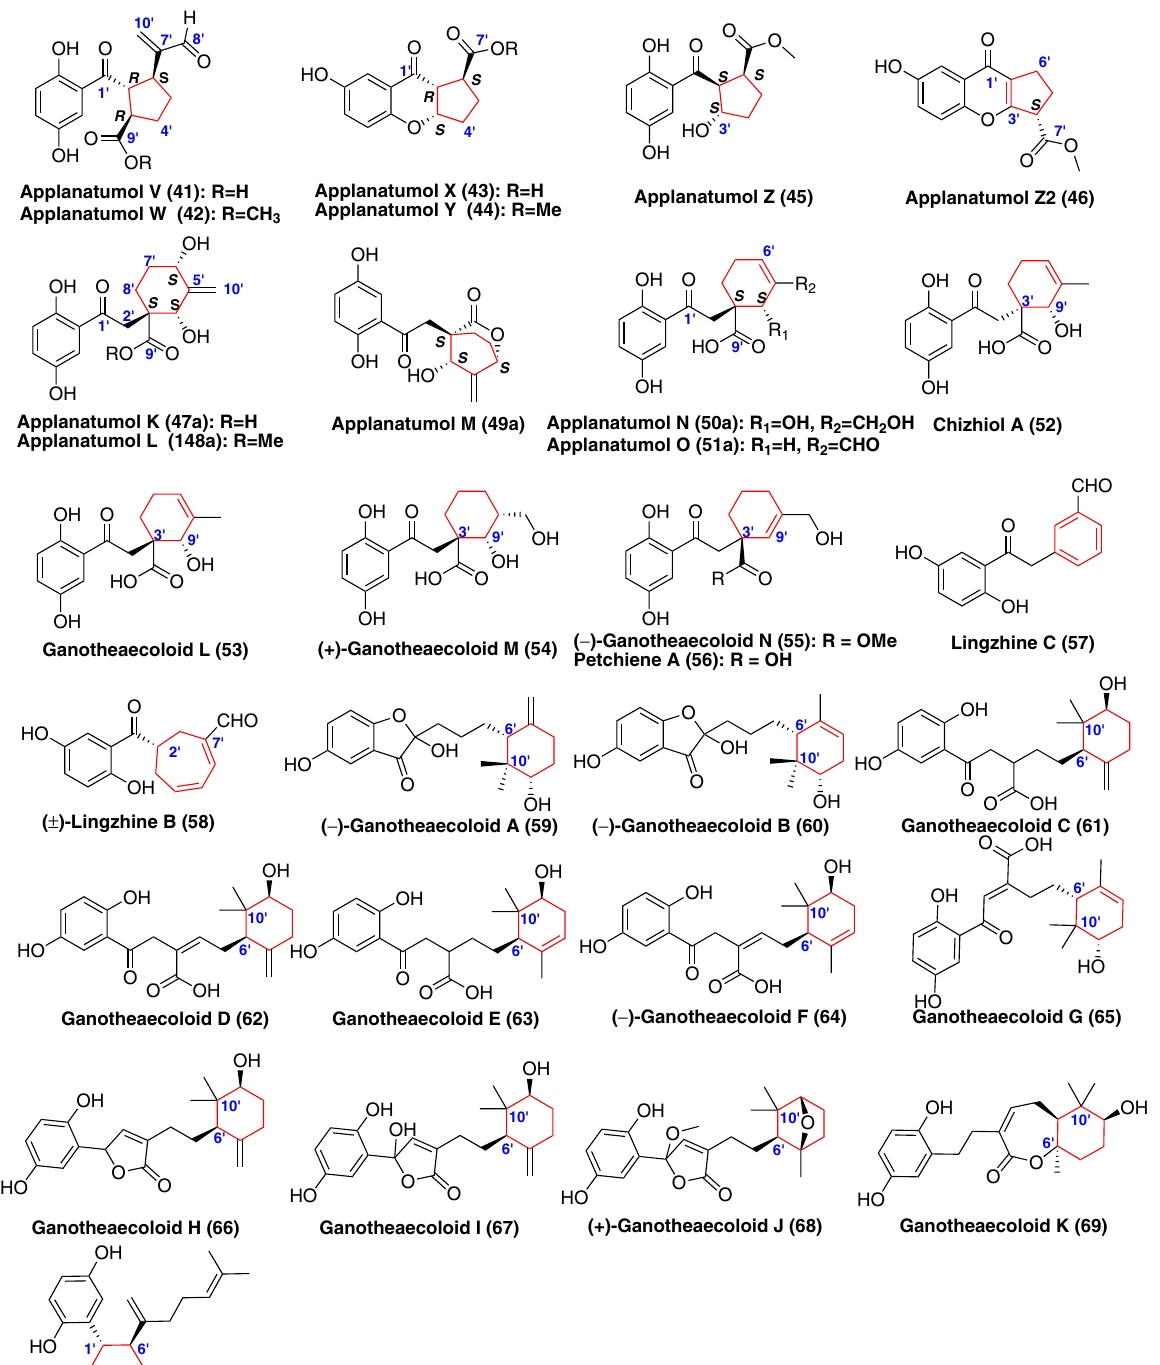
Fig. 5 Structures of GMs with a five-membered or six-membered carbon